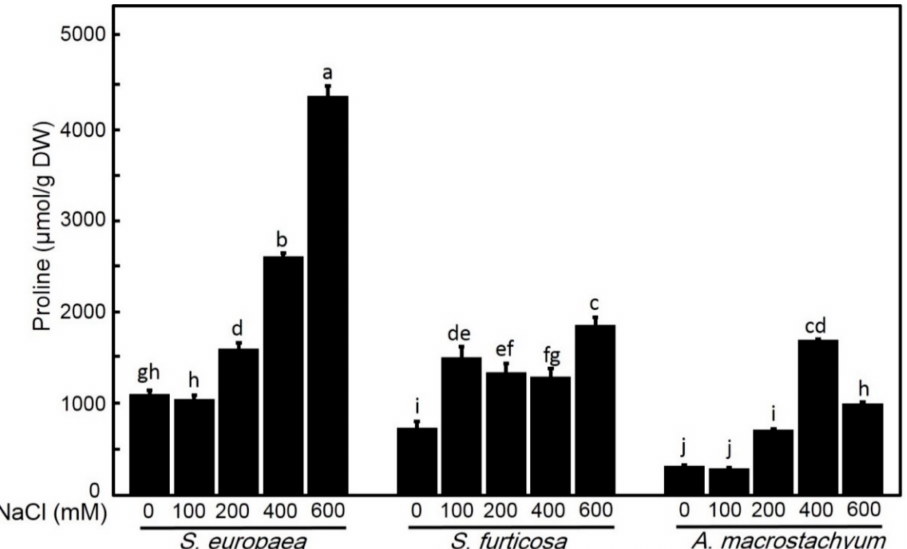
Figure 12. Proline contents of S. europaea, S. fruticosa and A. macrostachyum under different NaCl concentrations. Mean ± SE of three replicates. Different letters indicate significant differences ( p <